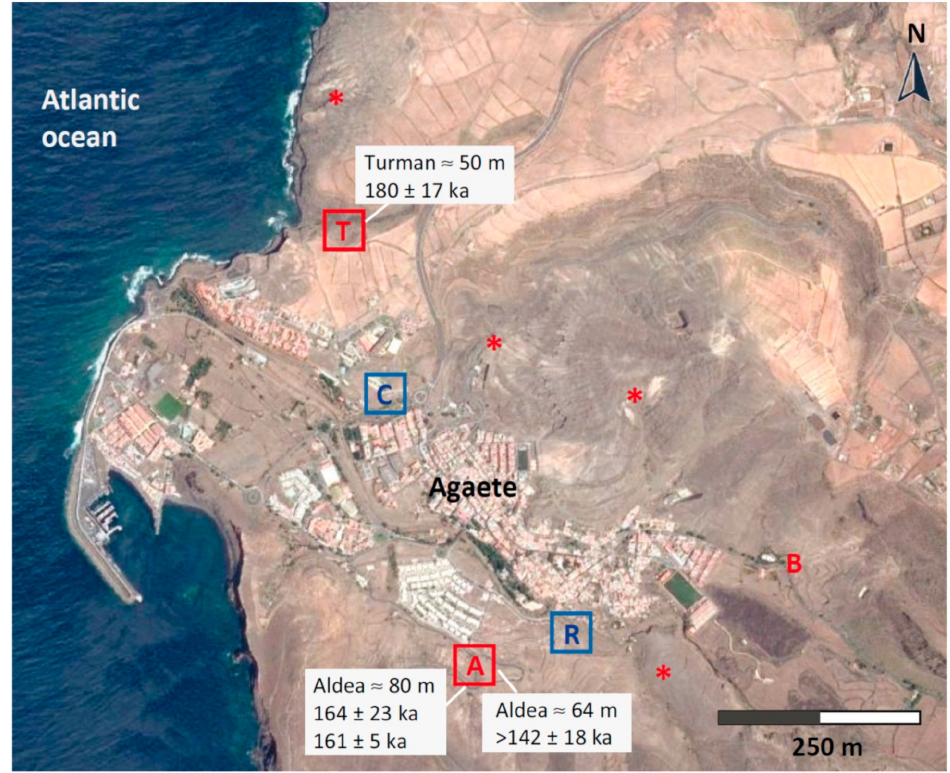
Figure 10. Location of the outcrops of tsunamigenic conglomerates in the area of Agaete (red stars and letters), first described in [8]. Outcrops cited in the text: Llanos de Turman (T); Berrazales (B); La Aldea (A). New outcrops referred in the text (blue): El Cementerio (C) and La Ruina (R). Ages obtained in this study for La Aldea and Llanos de Turman sites are included. Image from Google